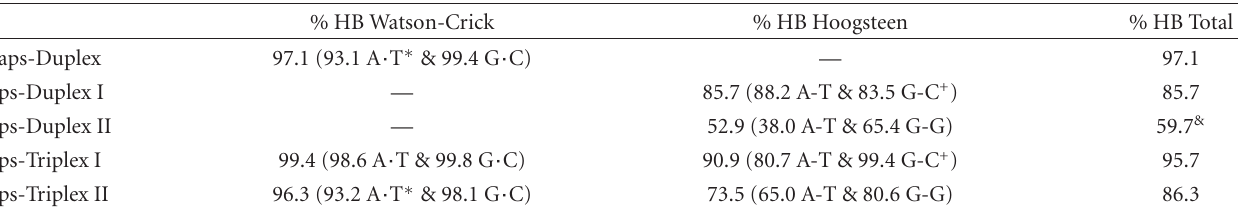
Figure 8: (a)-(b): Superposition of d(G-G) and d(G-C + ) pairs to the reference d(A-T) one in parallel DNA. (c)-(d): Superposition of d(G · C- G) and d(G · C-C + ) triads to the reference d(A · T-T) one in parallel triplex. In all the cases the central purine atoms were used as reference in the fitting. Table 4: Percentage (from maximum number possible) of hydrogen bond detected in the di ff erent simulations. Partition between di ff erent types or pairs (A · T, A-T, G · C + , and G-G) is included. & The total number of hydrogen bond includes reverse Watson-Crick hydrogen bonds detected in the